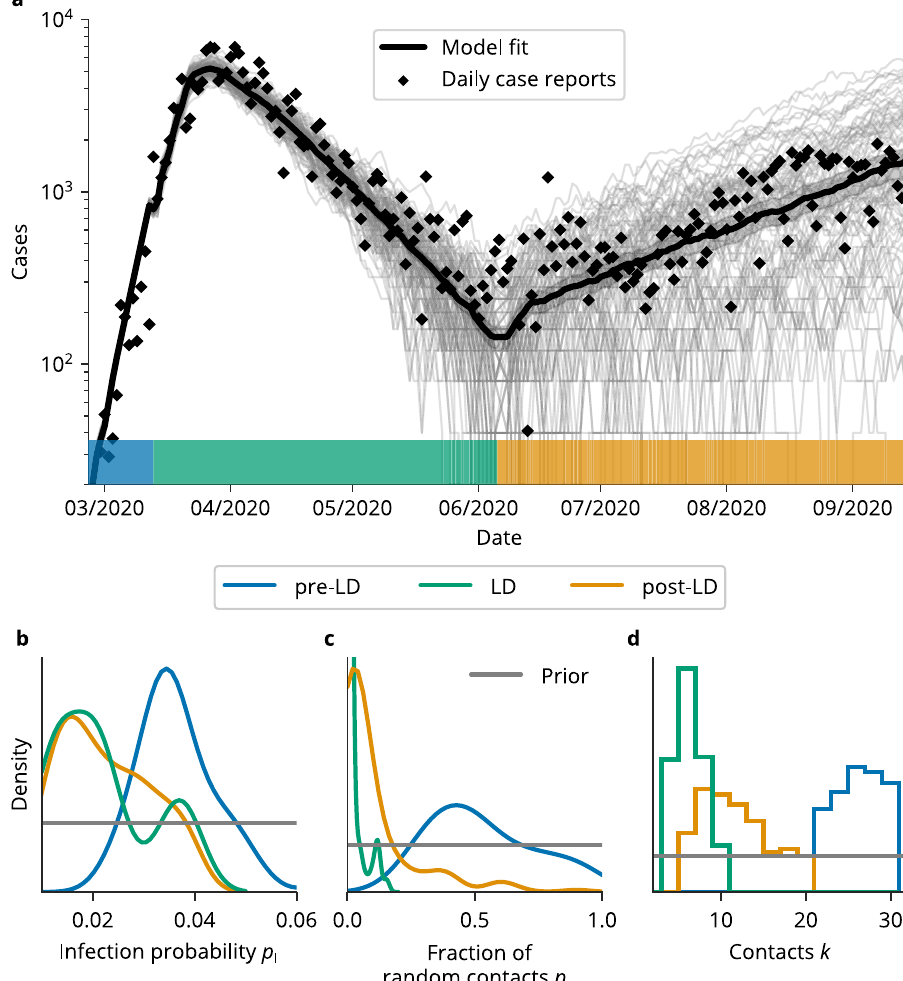
Figure 3. Inference of key epidemiological parameters before (pre-LD, blue), during (LD, green) and after (post-LD, yellow) the lockdown in Germany. ( a ) Daily case reports (black diamonds), single model instances (gray lines) and their mean (black line, error band corresponds to 95% error of the mean). Colors indicate the respective time periods, where the color is the same as that of the corresponding posterior parameter distributions in ( b–d ). Model parameters were chosen as the median of the respective posterior distribution. ( b–d ) Kernel density estimates of the posterior parameter distributions. The uniform prior distribution is 0.035 (CI [0.025, 0.061]) pre-lockdown to shown in gray. ( b ) The infection probability p I decreased from p I = 0.02 (CI [0.01, 0.04]) during the lockdown. After most restrictions were lifted, the infection probability p I = 0.02 (CI [0.01, 0.04]). ( c ) The fraction of random contacts in the remained almost unchanged at p I = 7 , 0.12 5 (CI 10 0.48 (CI [0.23, 0.94]) to p 8 10 transmission network p decreased strongly from p ) − − [ ] = = × 0.03 (CI [0.001, 0.60]) when they were lifted. ( d ) The when restrictions were put in place and increased to p = 26 (CI [22, 32]) to k 6 (CI [4, 10]) during lockdown total number of contacts k decreased strongly from k = = 12 (CI [6, 20]) after restrictions were before increasing again to k =